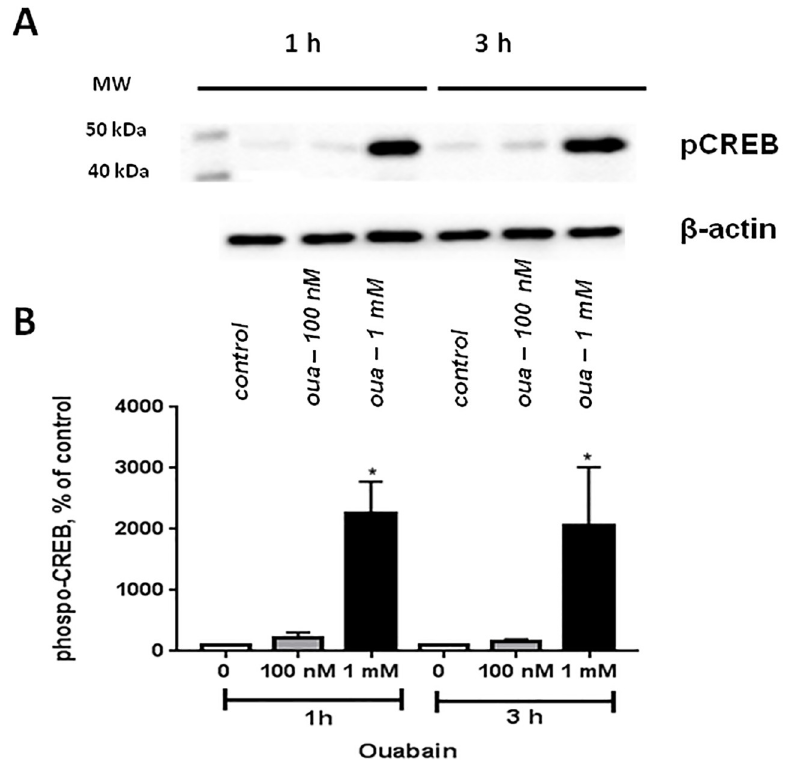
Fig 4. Effect of ouabain (oua) on CREB phosphorylation in cerebellum granule cells. A representative Western blot ( A ) and means ± SD for 4 independent experiments ( B ) are shown. � –p < 0.05 compared to control.